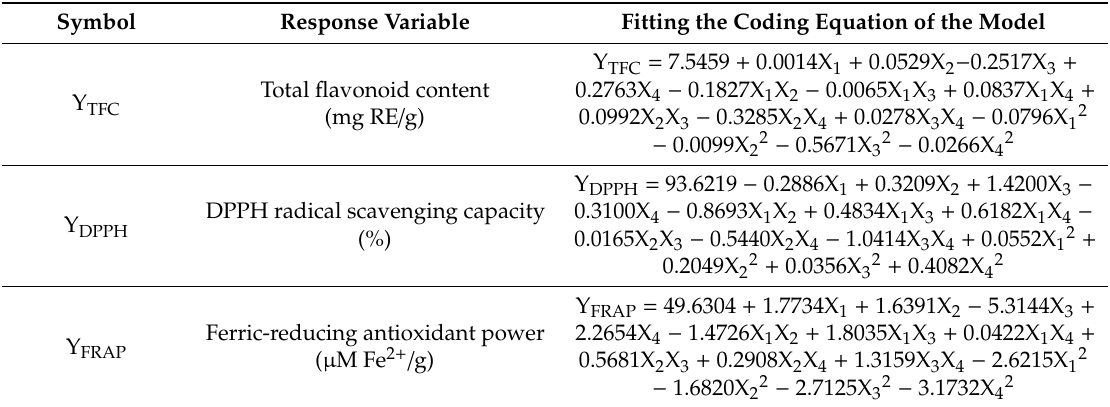
Table 1. Response variables and their fitted model equations.